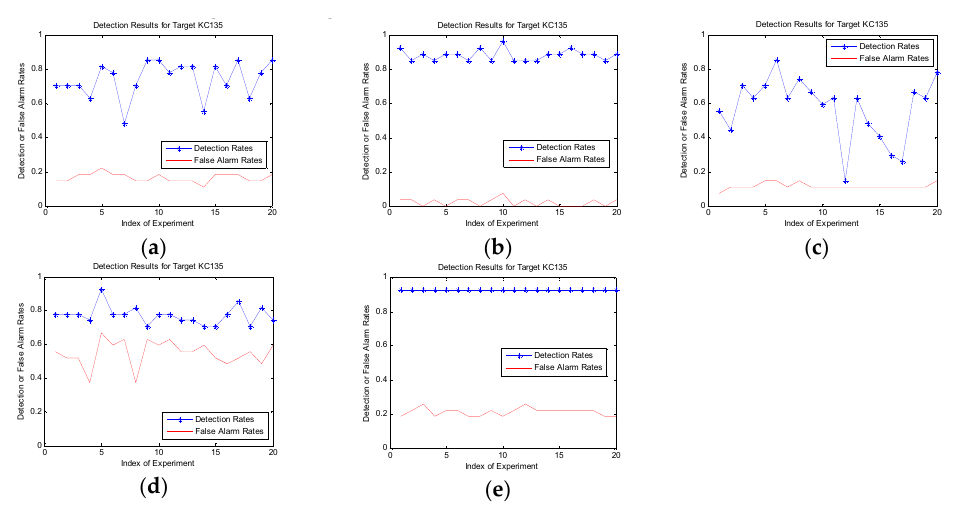
Figure 12. Detection results in different feature space. Constraint training and testing samples in different feature spaces are: ( a ) small- samples SAR set without any processing; ( b ) whole samples in optical set A without any processing; ( c ) and ( d ) the slices after framework extraction of ( a ) and ( b ) respectively; ( e ) the slices after FA.